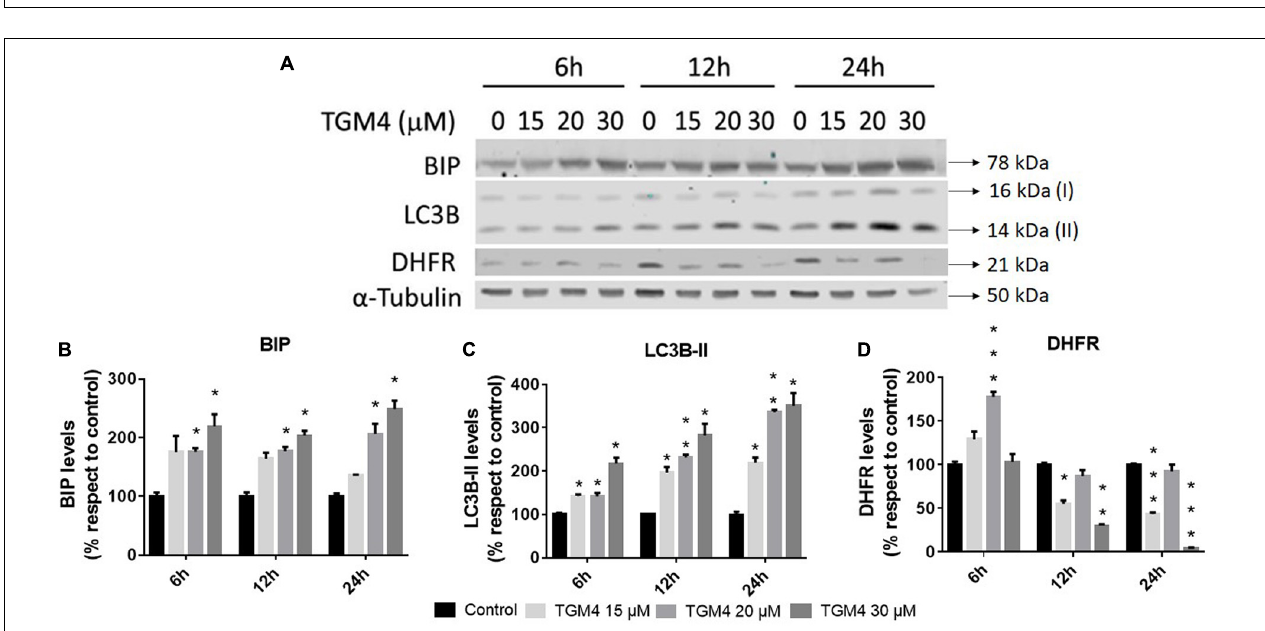
FIGURE 5 | Protein analysis of PANC-1 cells treated with TGM4 at different doses and times. Representative immunoblots (A) and quantification (B–D) of BIP, LC3-II, and DHFR proteins. Data were normalized by α -tubulin. Each value represents the mean ± SEM ( n = 3) expressed as a percentage with respect to control (100%). The significance was determined by a t -test (* p < 0.05; ** p < 0.01; *** p < 0.001).